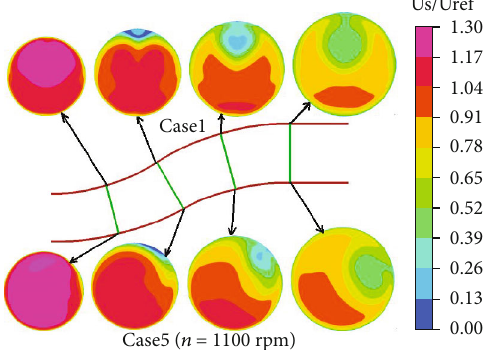
Figure 8: Contour of total pressure. Figure 9: Contour of streamwise